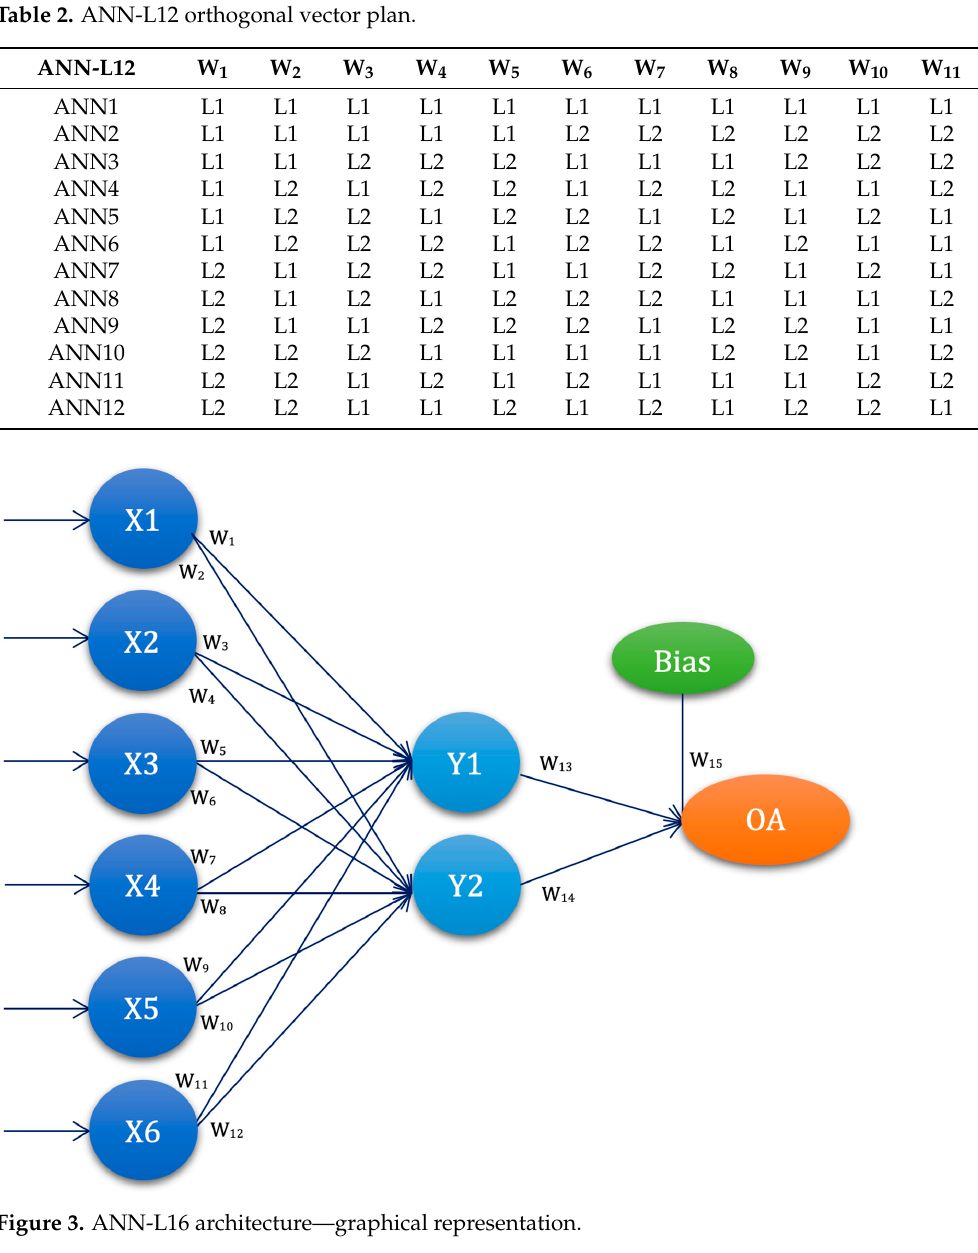
Table 3. ANN-L16 orthogonal vector plan. ANN- L16